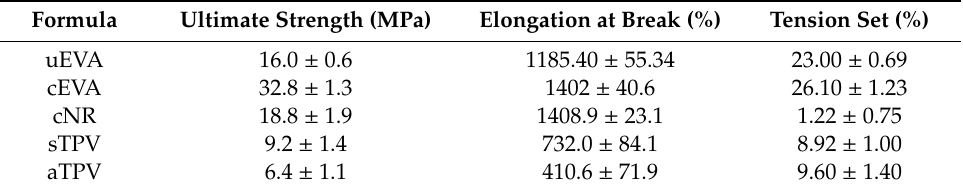
Table 3. Tensile properties and tension set of pure EVA, cured NR, and EVA / NR TPVs samples prepared with di ff erent methods.